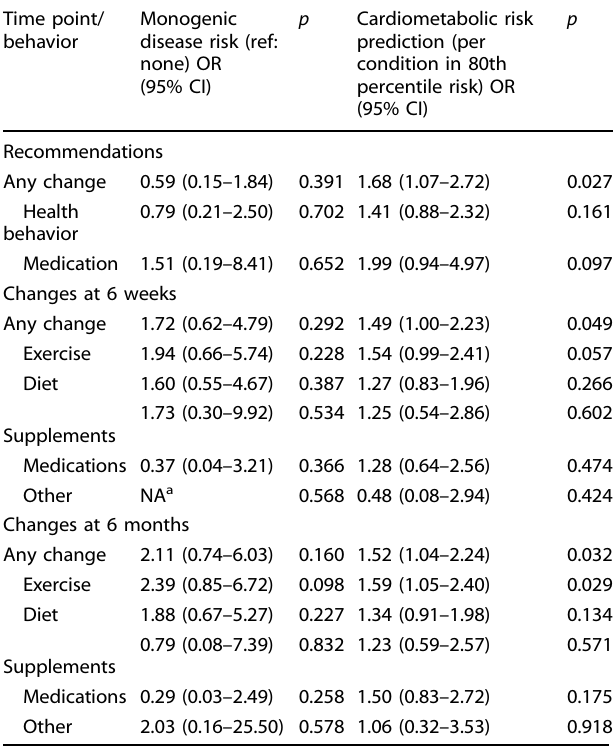
Table 3. Associations between high-risk results, provider recommendations, and patient-reported health behavior